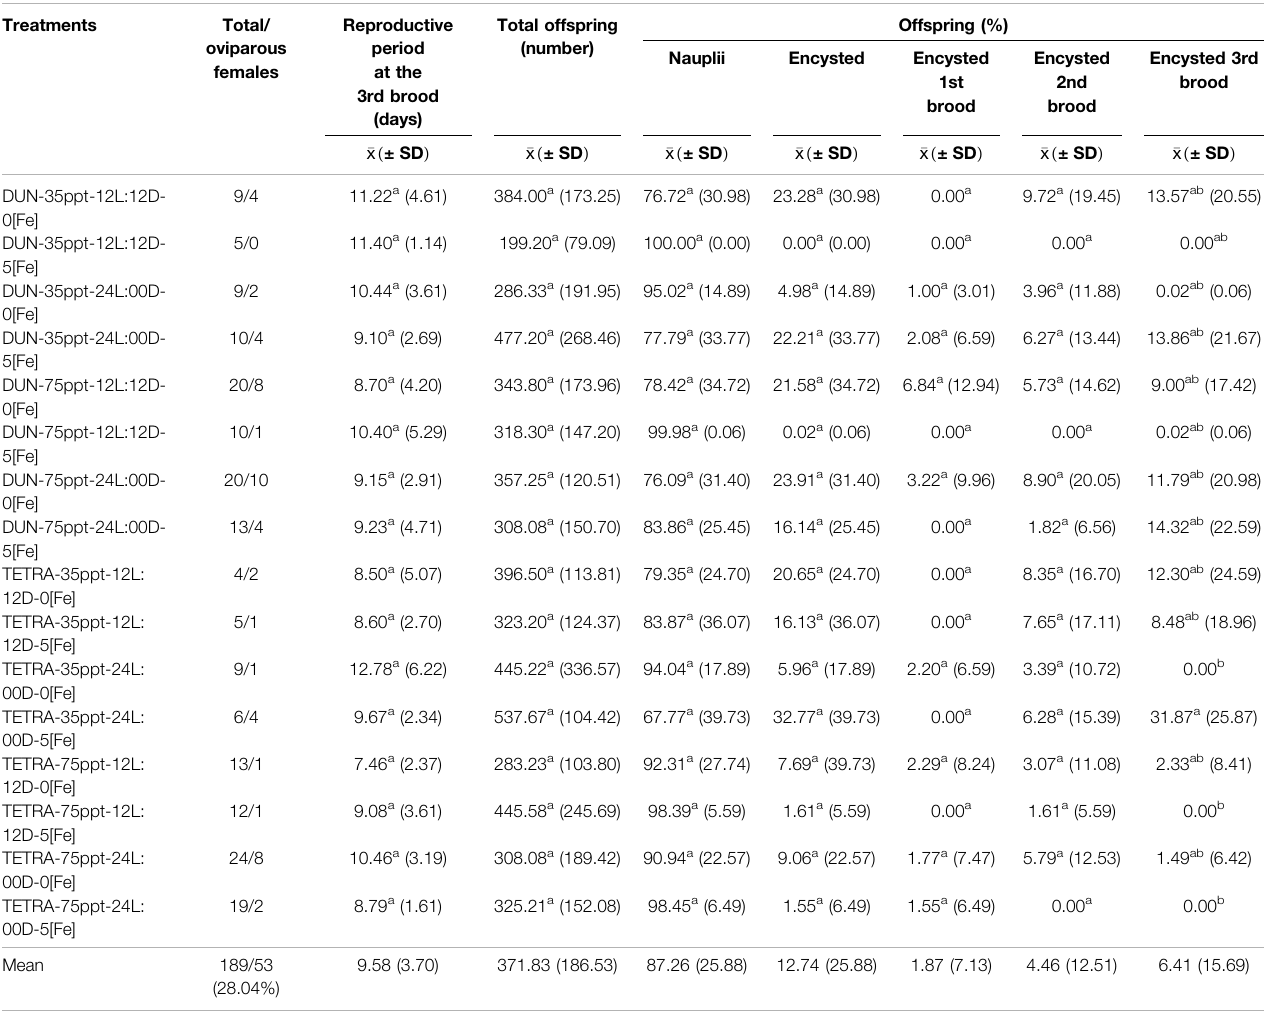
TABLE 4 | Summary of reproductive parameters of 16 treatments recorded for the San Francisco Bay population.